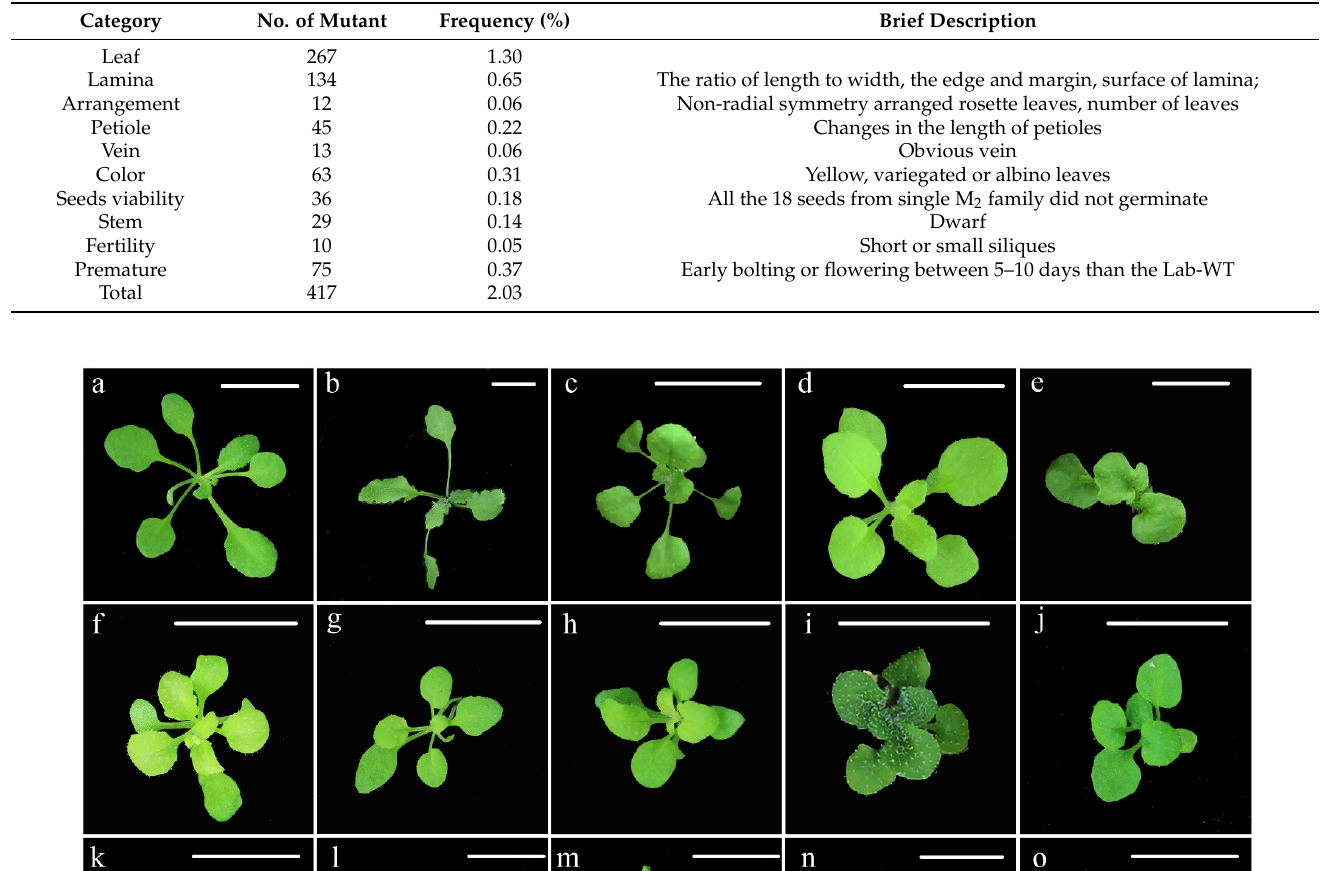
Table 1. Classification of visible mutation phenotype induced by gamma rays in M 2 generation.